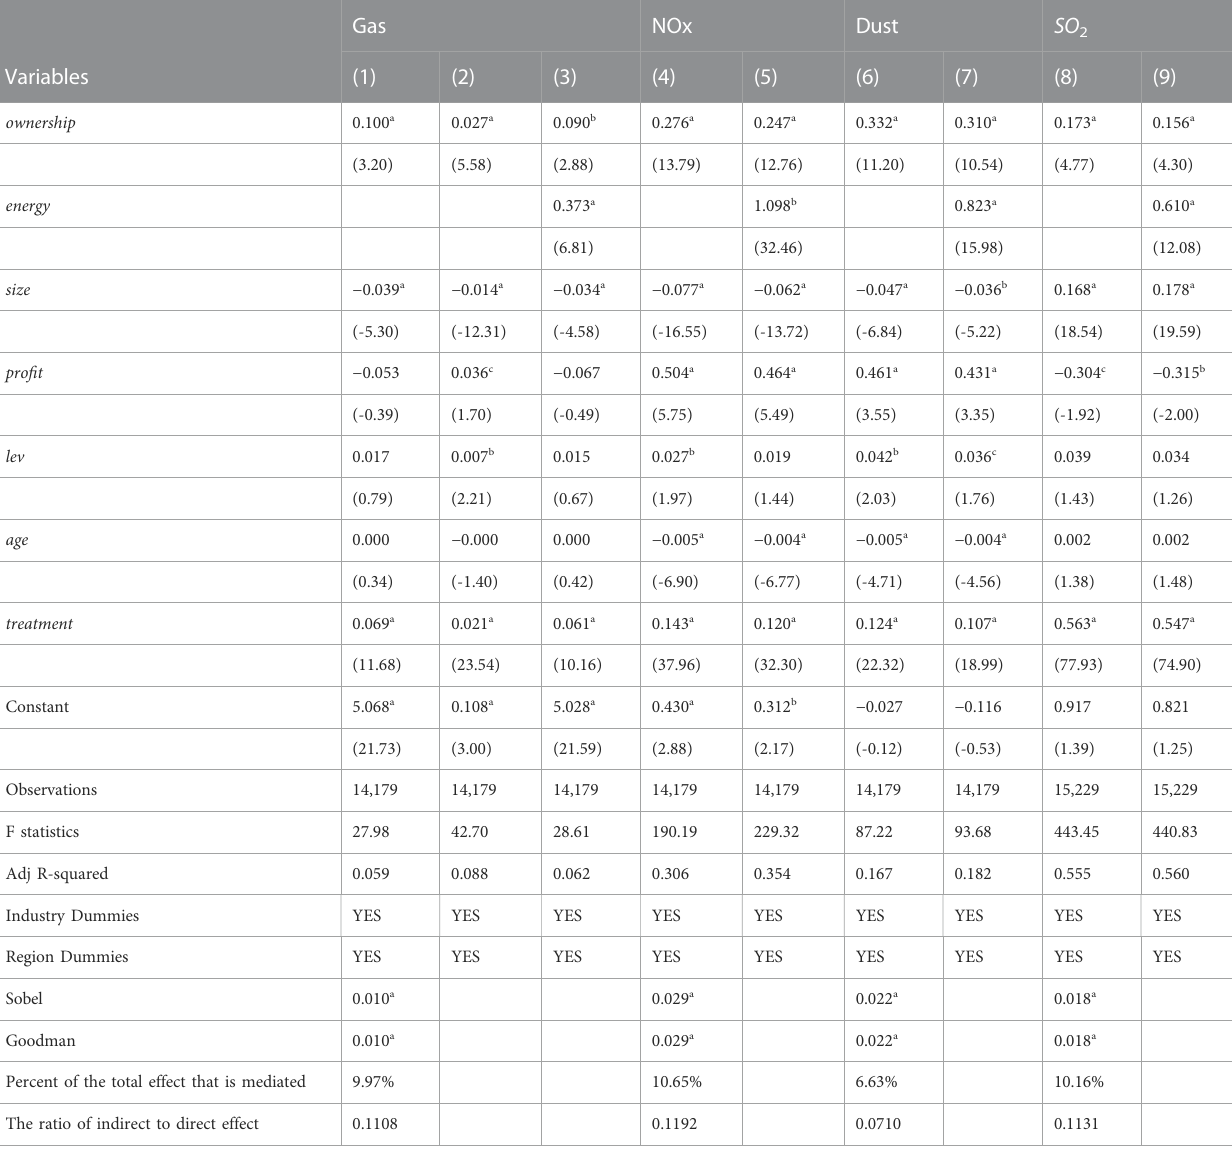
TABLE 5 Mediation effect regressions (robustness